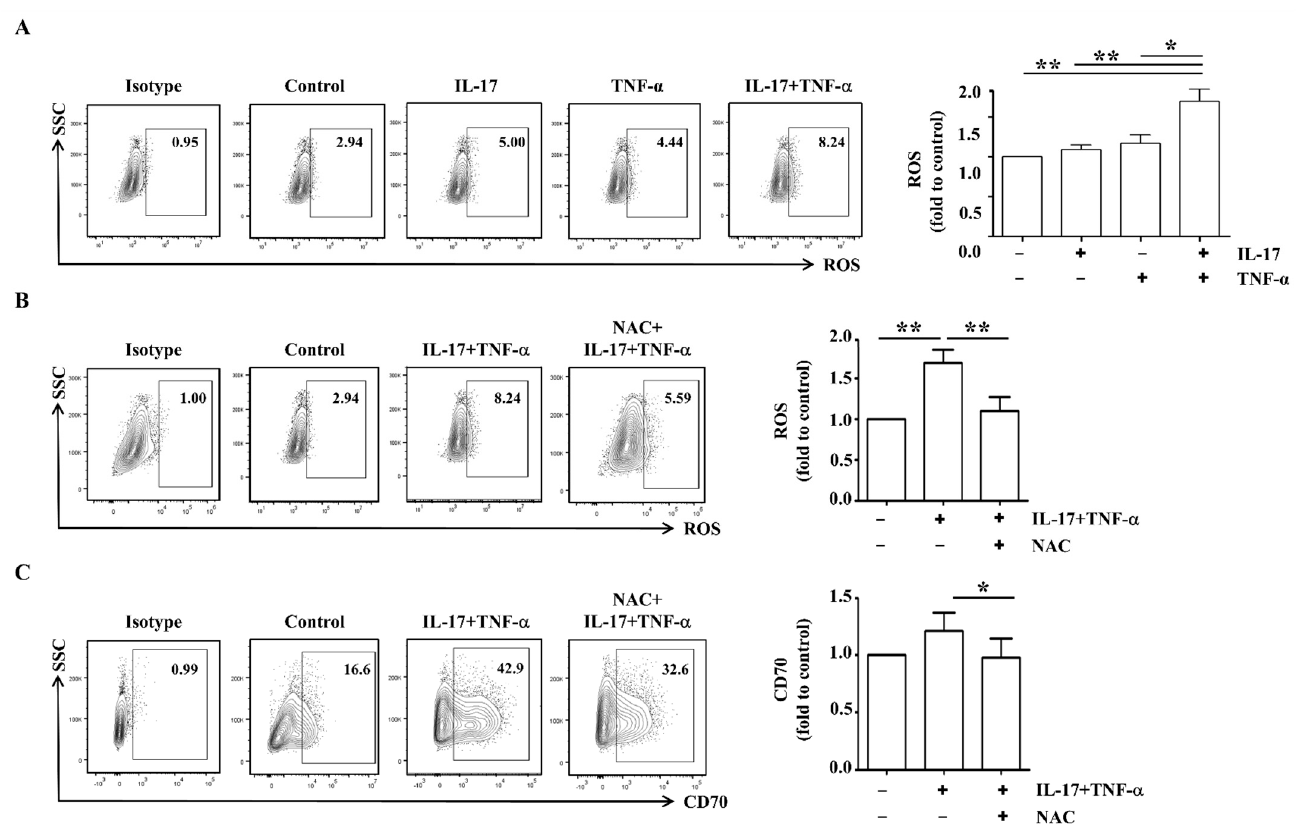
Figure 3. IL-17 and TNF- α enhance ROS expression in RA FLS. ( A ) RA FLS ( n = 8) were cultured with or without IL-17 (5 ng/mL) and TNF- α (5 ng/mL) for 24 h. To analyze ROS expression, flow cytometry analysis was performed using DCFDA. Data from one representative experiment are presented (left). Average ROS expression was displayed as fold change of the MFI compared to control (right). ( B ) RA FLS ( n = 8) were pre-incubated with 10 nM of NAC for 1 h, and then, cells were stimulated with or without IL-17 (5 ng/mL) and TNF- α (5 ng/mL) for 24 h. To analyze ROS expression, flow cytometry analysis was performed using DCFDA. Data from one representative experiment are presented (left). Average ROS expression is displayed as fold change of the MFI compared to control (right). ( C ) RA FLS ( n = 5) were pre-incubated with 10 nM of NAC for 1 h, and then, cells were stimulated with or without IL-17 (5 ng/mL) and TNF- α (5 ng/mL) for 24 h. To analyze the surface expressions of CD70, flow cytometry analysis was performed using PE-conjugated anti- CD70. Data from one representative experiment are presented (left). Average CD70 expression was calculated as fold change of the MFI compared to control (right). Statistical analysis was performed using a Mann–Whitney test. * indicates p < 0.05; ** indicates p < 0.01.